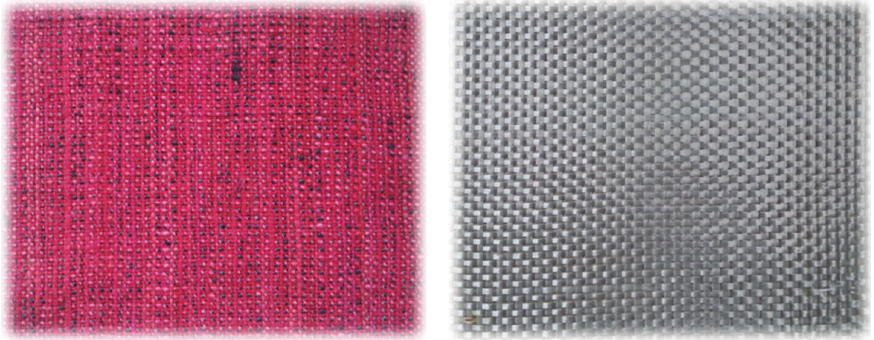
Figure 1: Kenaf and glass